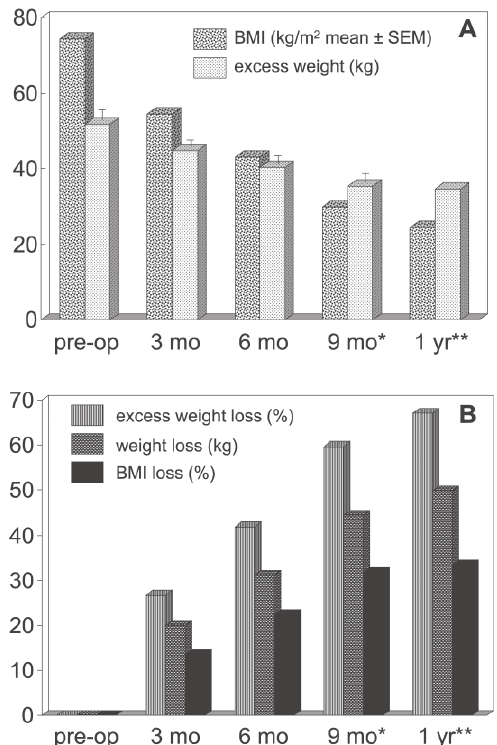
Figure 1 - The evolution of body weight and body mass index (A) over the entire interval. Losses (B) are cumulative over the post-operative period; (*) 9 month values relate to 32 patients; (**) 1 year values relate to 13 subjects – not submitted to